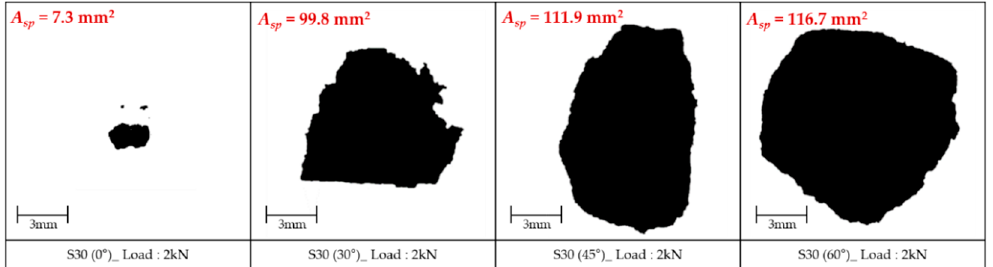
Figure 15. Spalling area of S-fiber sample according to inclination angle at air pressure of 2 kN.